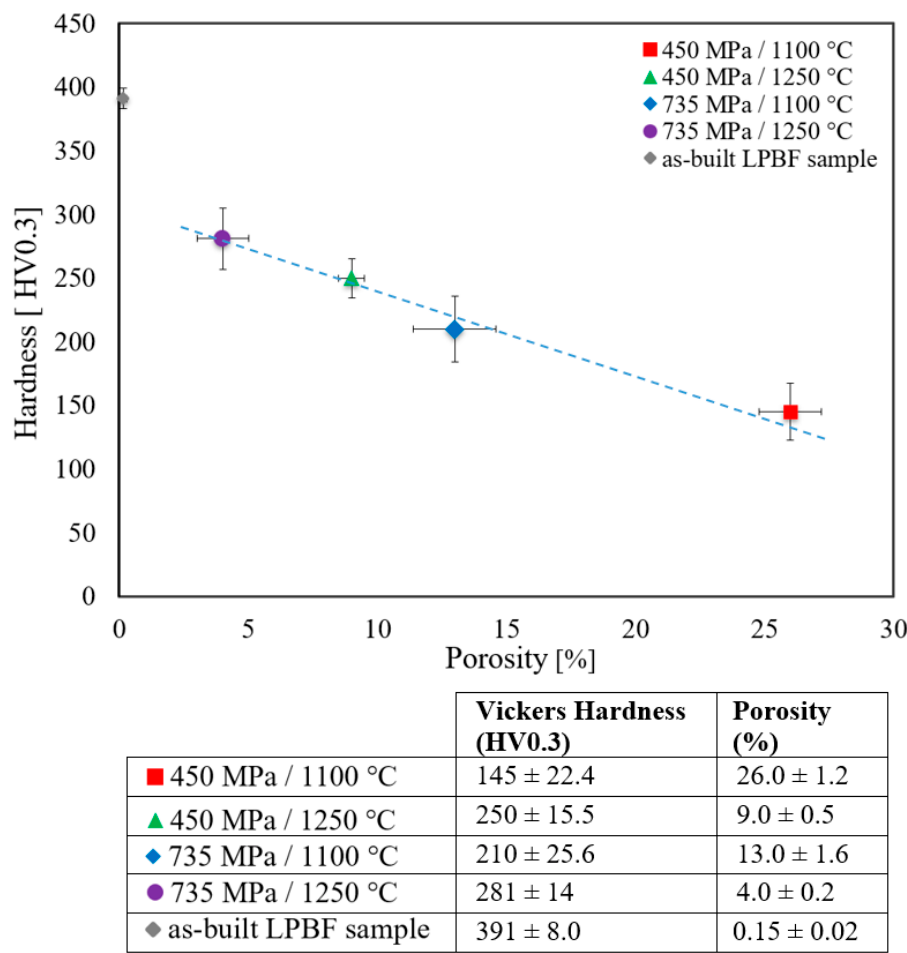
Figure 9. Hardness of PM and L-PBF samples vs. their porosity contents.